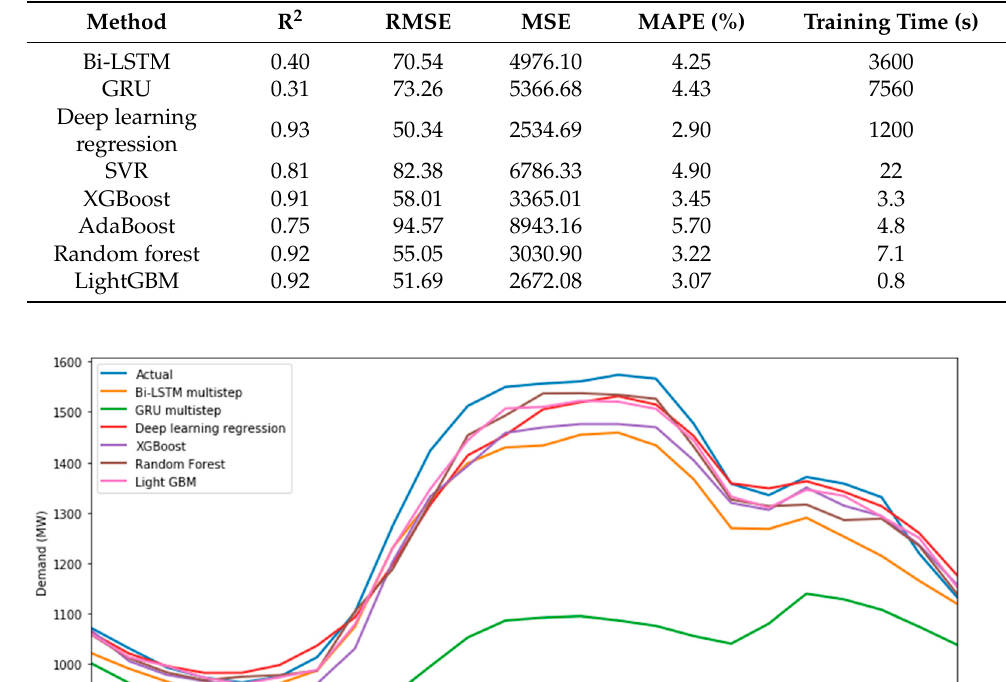
Table 8. Results of the models for Short-term Electricity Forecasting.